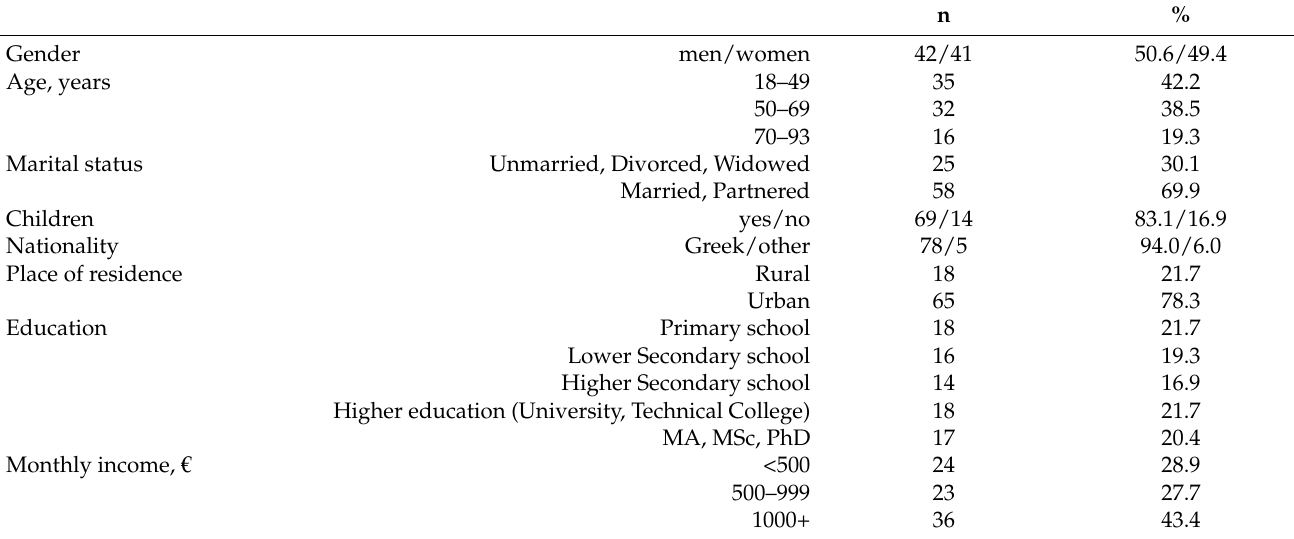
Table 1. Descriptive characteristics of the 83 study